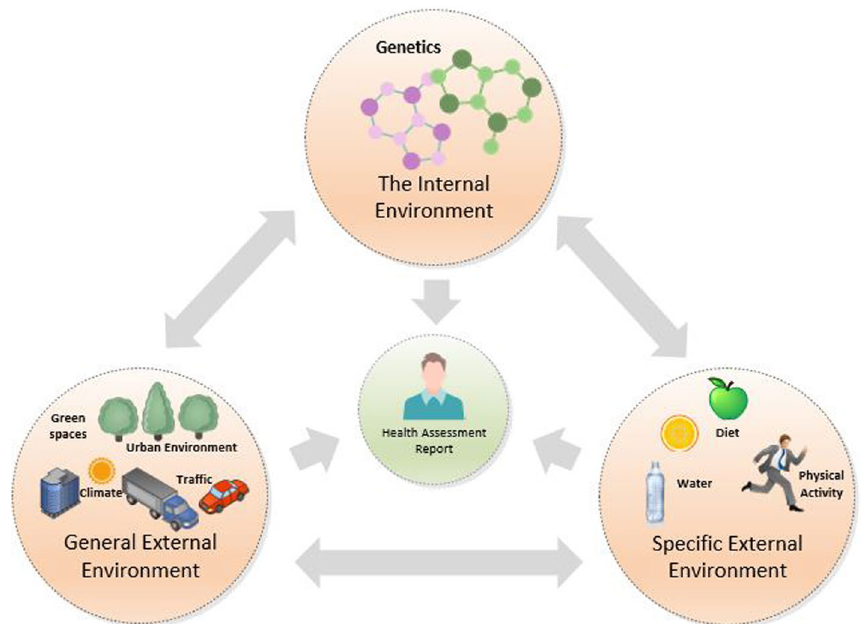
Fig. 1 The three stages of the Exposome concept depicting how each plays a part in calculating the health assessment risk for an